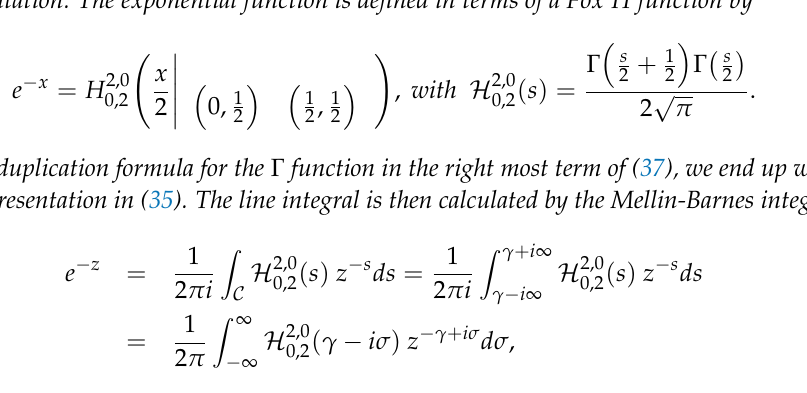
Figure 1. Numerical representation of the Fox H function H 2,0 based on (35) using N = 24 Sinc points for x . The L 2 norm over the local error delivers a value of 1.784 10 − 6 .